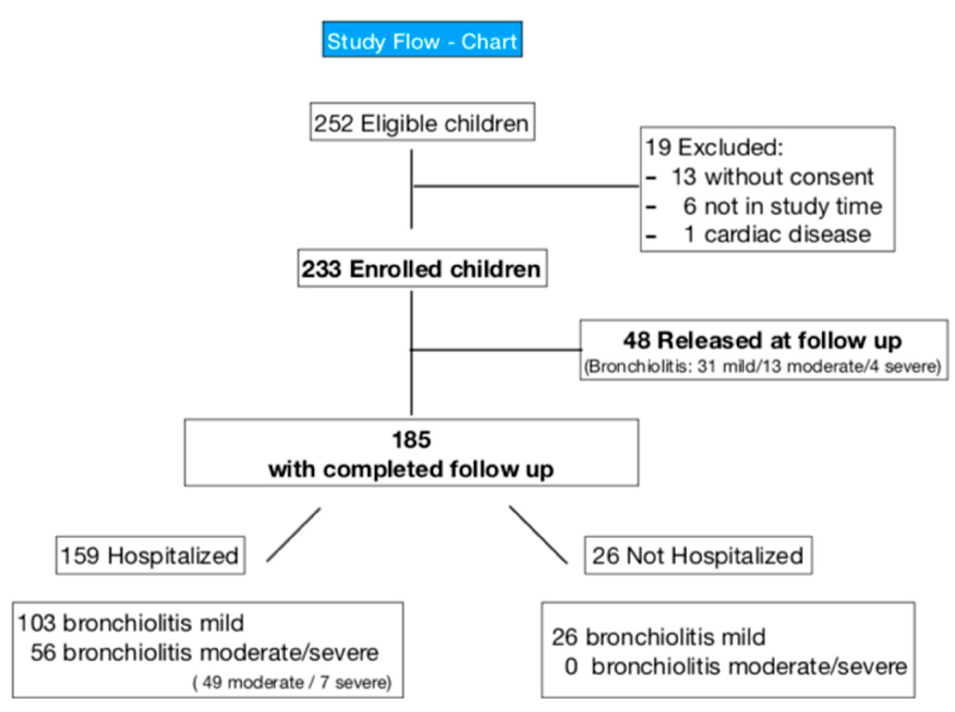
Figure 3. Study flow-chart. Table 2. Study Population. RSV: respiratory syncytial virus. * Home therapy before hospital